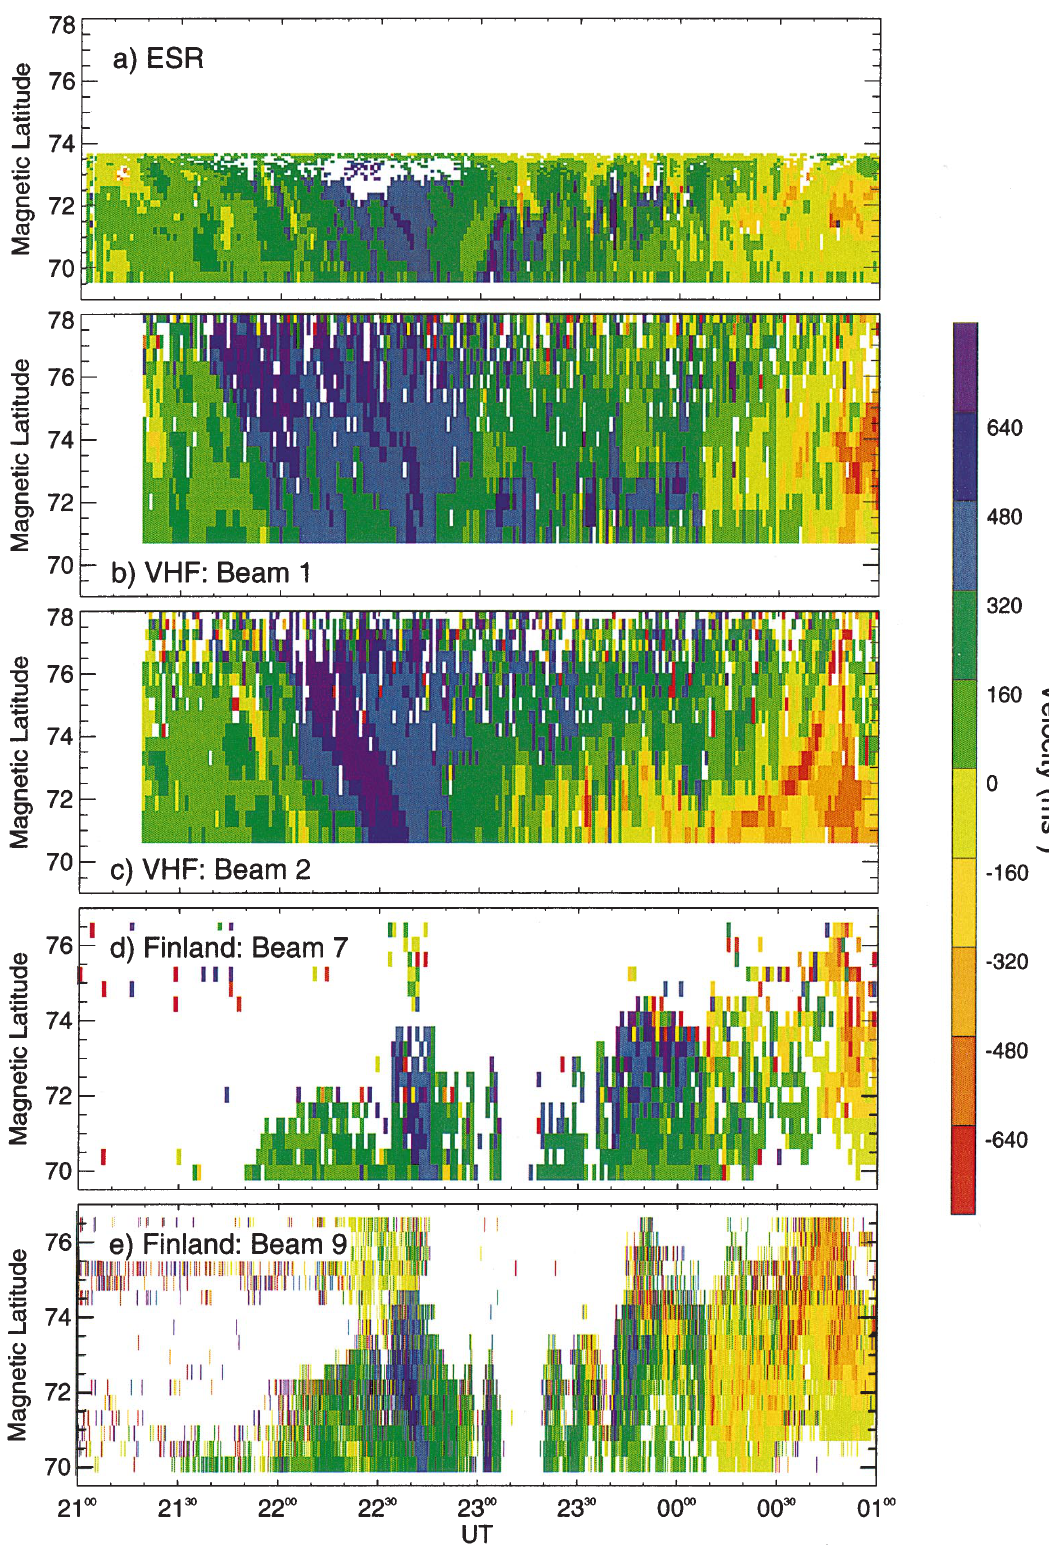
Fig. 2a–e. Line-of-sight velocity measurements during the SP-UK- CSUB experiment run from 2100 UT on 21 August to 0100 UT on 22 August, 1998. Successive panels illustrate data from a the EISCAT